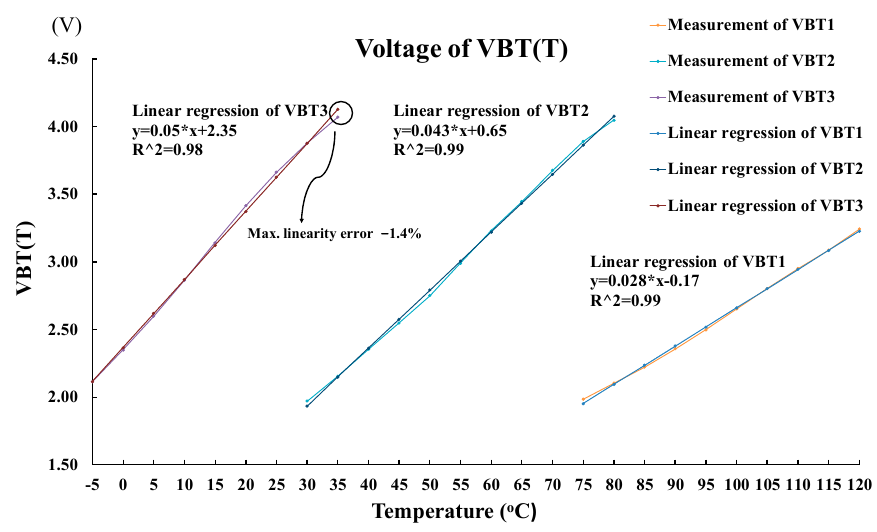
Figure 12. The measurement result of the VBT ( T ) with respect to a linear asymptotic line.